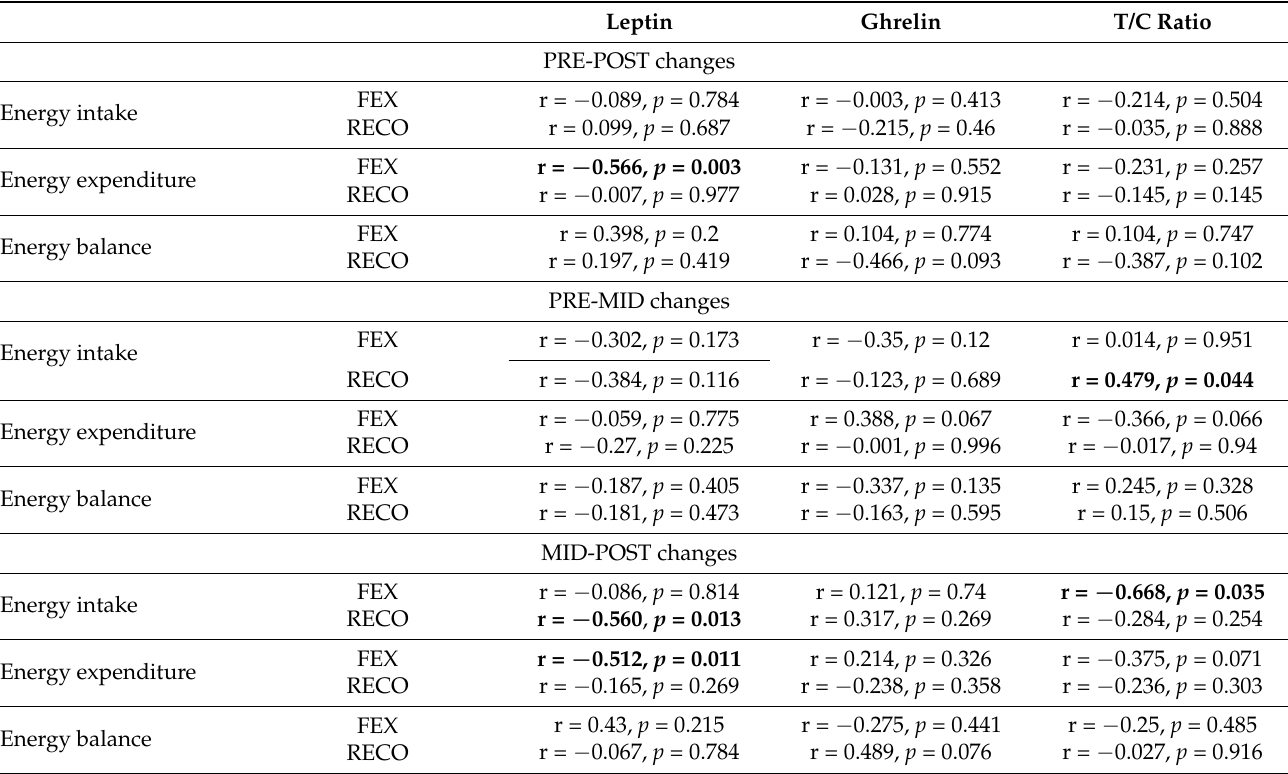
Table 4. Associations of changes in energy intake, energy expenditure, and energy with changes in leptin, ghrelin, and testosterone/cortisol ratio (T/C ratio). Statistically significant associations have been